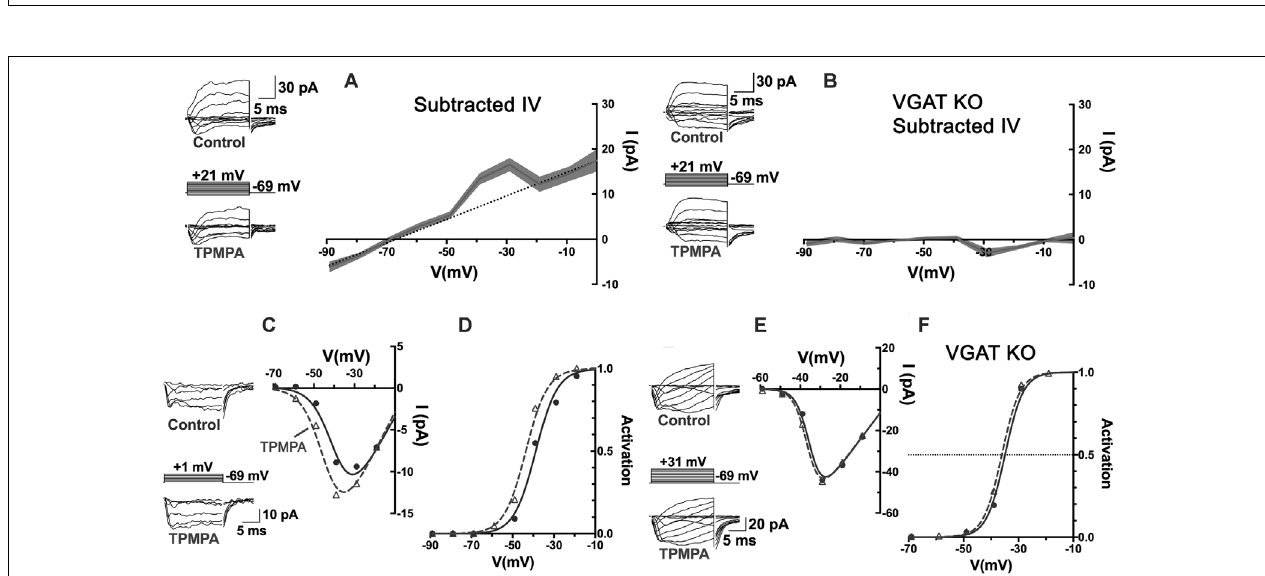
FIGURE 7 | An autaptic mechanism: horizontal cells release GABA and respond to it via ρ -subunit-containing GABARs, and feedback to cones depends upon it. (A) Patch-clamp recording of Cx57-tdTomato labeled mouse horizontal cells in a slice bathed in CNQX (50 µ M) and Hepes buffer (10 mM, pH 7.4) to isolate it from feedback and cone input. Whole-cell currents were elicited in horizontal cells with voltage steps, in control and in TPMPA (50 µ M). Averaged I–V relations of steady-state TPMPA-subtracted currents showed a linear component reversing near − 70 mV. Linear fitting excluded values near − 40 and − 30 mV. Gray shading shows the standard deviation of 5 horizontal cell recordings. (B) Same experiment and protocol as in panel (A) but recorded from Cx57-VGAT KO mouse horizontal cells that lack VGAT, which have synaptic vesicles devoid of GABA (Hirano et al., 2016). The mouse horizontal cells lacking VGAT were unaffected by TPMPA, suggesting that the tonic GABA levels in the wild-type are due to horizontal cell release and autaptic reception. (C) Recording of cone Ca V channel currents in a wild-type mouse, showing current in control and in presence of TPMPA, with I–V relations. (D) Activation curves showed that the Ca V channel activation midpoint shifted negative by about 5 mV in presence of TPMPA. Same experimental protocol as in panel (C) but in a Cx57-VGAT KO mouse cone, showing that the I–V relations (E) and the activation midpoints (F) were unaffected by TPMPA in cones when horizontal cells were unable to release GABA. Figure modified from Grove et al.